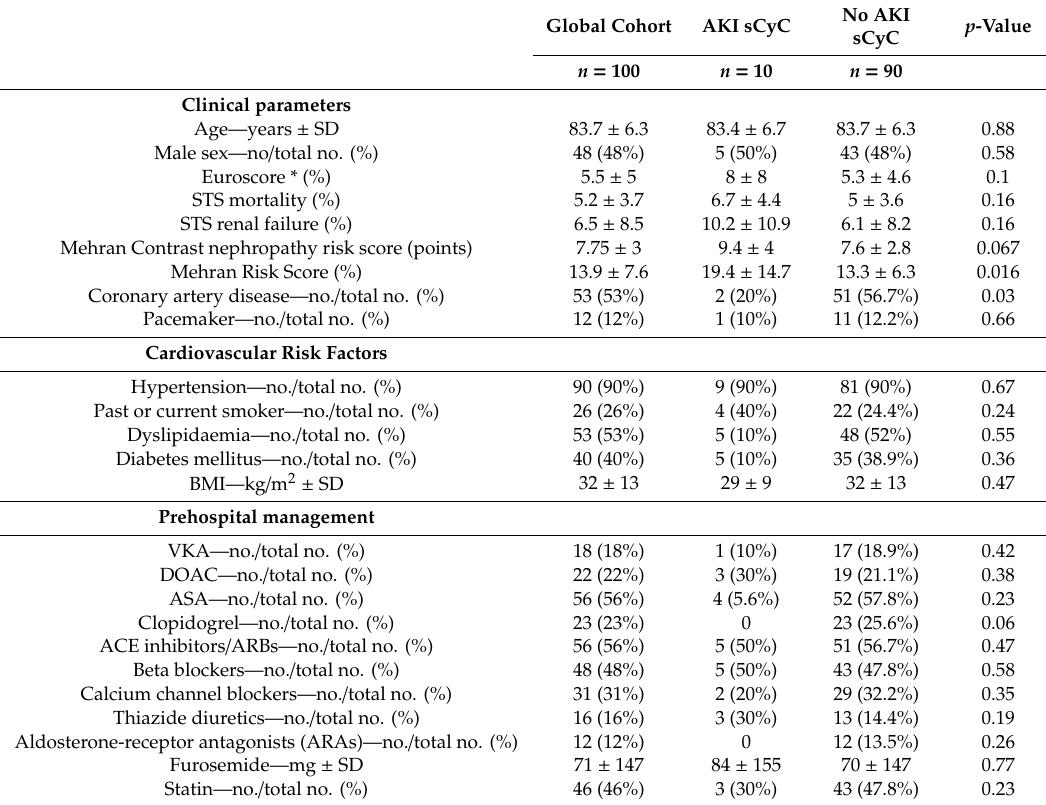
Table 1. Baseline